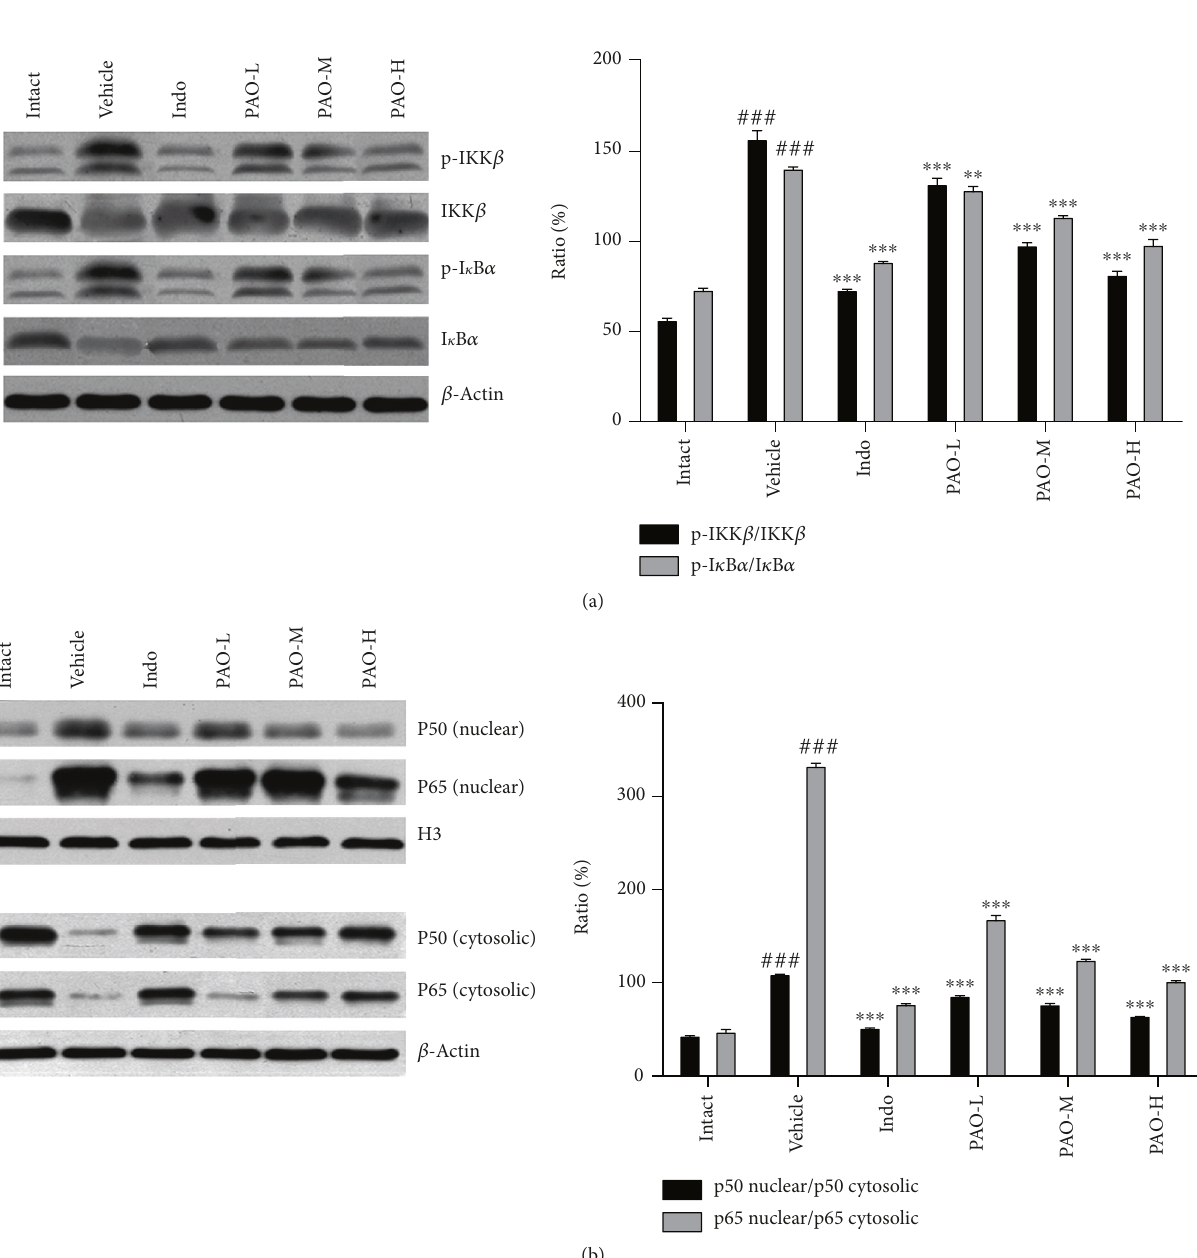
Figure 9: E ff ect of PAO on the expressions of NF- κ B pathway-related proteins in carrageenan-induced mouse paw. Indo: indomethacin (10 mg/kg); PAO-L: low dose of PAO (10 mg/kg); PAO-M: medium dose of PAO (20 mg/kg); PAO-H: high dose of PAO (40 mg/kg). Protein expression of p-IKK β , IKK β , p-I κ B α , I κ B α , and NF- κ B (p50 and p65) was measured by Western blot analysis. β -Actin and H3 were used as loading controls. Data were expressed as means ± SEM. ( n = 3 ), ### p < 0 001 versus the intact group. ∗∗ p < 0 01 , and ∗∗∗ p < 0 001 versus the vehicle